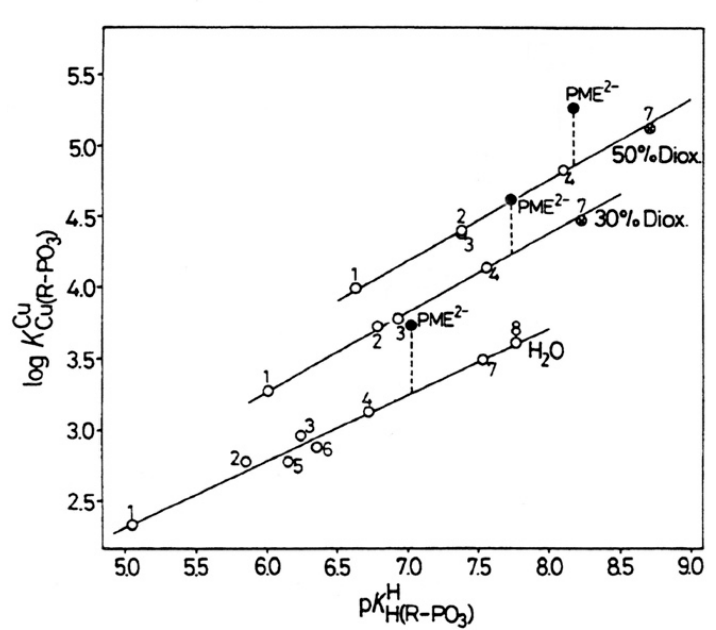
Figure 18. Evidence for an enhanced stability of the Cu(PME) ( • ) complex in 1,4-dioxane-water mixtures as solvents, based on the relationship between log K Cu and p K H H ( R − PO 3 ) Cu ( R − PO 3 ) for the Cu 2+ 1:1 complexes of 4-nitrophenyl phosphate (1), phenyl phosphate (2), D-ribose 5-monophosphate (3), n -butyl phosphate (4),uridine 5 (cid:48) -monophosphate (5), thymidine [= 1-(2 (cid:48) -deoxy- β - D-ribofuranosyl)thymine] 5 (cid:48) -monophosphate (6), methanephosphonate (7), and ethanephosphonate (8) in water and in water containing 30% or 50% ( v / v ) 1,4-dioxane. The least-squares lines are drawn in each case through the data sets shown [44,150]; the equations for these reference lines are given in Ref [149]. The data points due to the methanephosphonate system in the mixed solvents ( ⊗ ,7) (see Ref [149]) are shown to prove that simple phosphonates fit within the experimental error limits on the reference lines established with phosphate monoester systems (see also Ref [149). The points due to the Cu 2+ 1:1 complexes formed with PME 2 − ( • ) in the three mentioned solvents demonstrate the enhanced complex stabilities. The vertical broken lines emphasize the stability differences to the reference lines; these differences equal log Δ Cu(R-PO3) , as defined in Equation (12). All the plotted equilibrium constants refer to 25 °C and I = 0.1 M (NaNO 3 ). This figure is adapted with permission from our publication in Inorganic Chemistry [149]; copyright 1993, American Chemical Society (see also [45]).